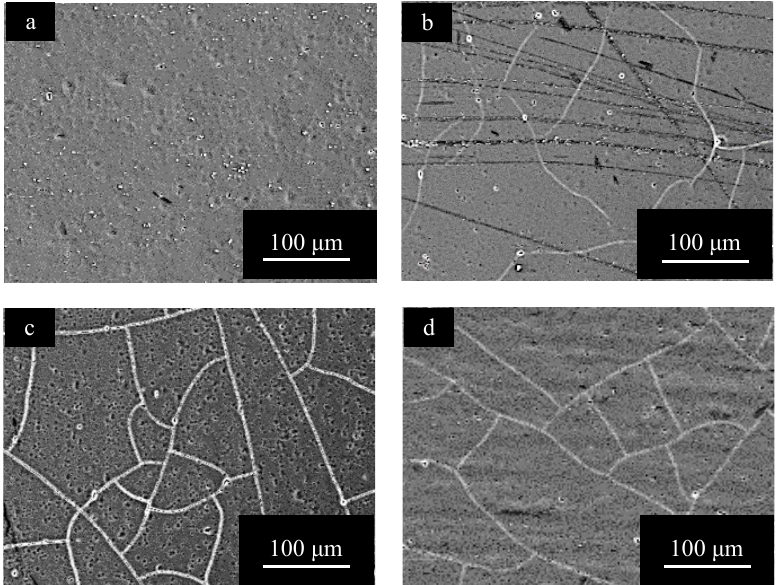
Figure 10. SEM images of the surface of specimens with t a = 3600 s and t s = 1200 s, obtained for ( a ) pure Al, ( b ) 1050-Al alloy, ( c ) 3003-Al alloy, and ( d ) 5052-Al alloy. Anodizing condition is described in Figure 3, and pore sealing condition is described in Figure 9.